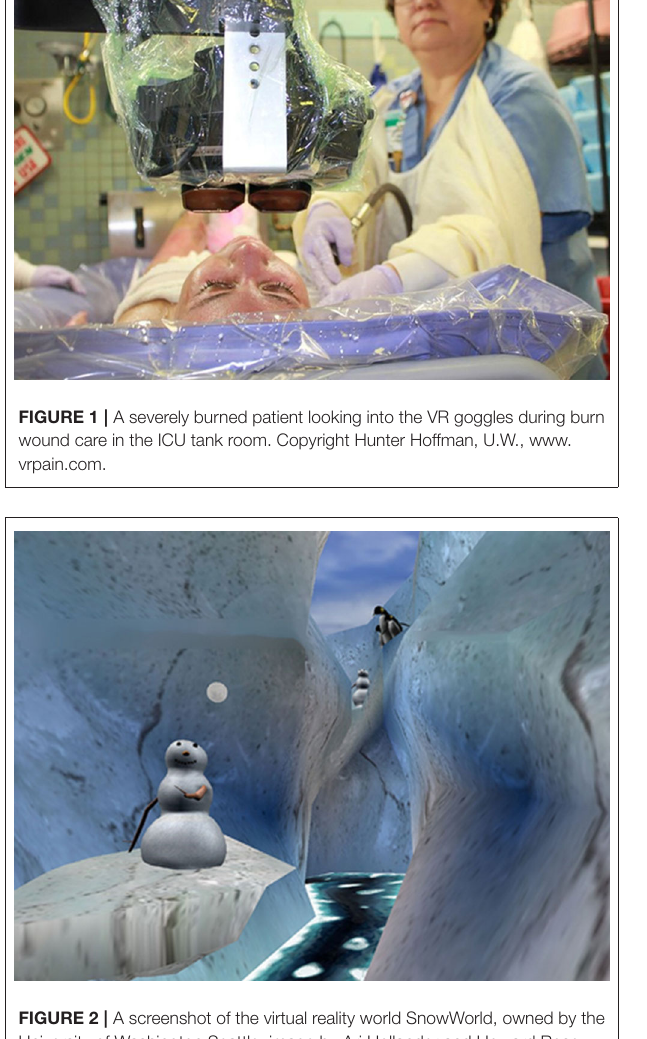
FIGURE 2 | A screenshot of the virtual reality world SnowWorld, owned by the University of Washington Seattle, image by Ari Hollander and Howard Rose, copyright Hunter Hoffman, U.W.,